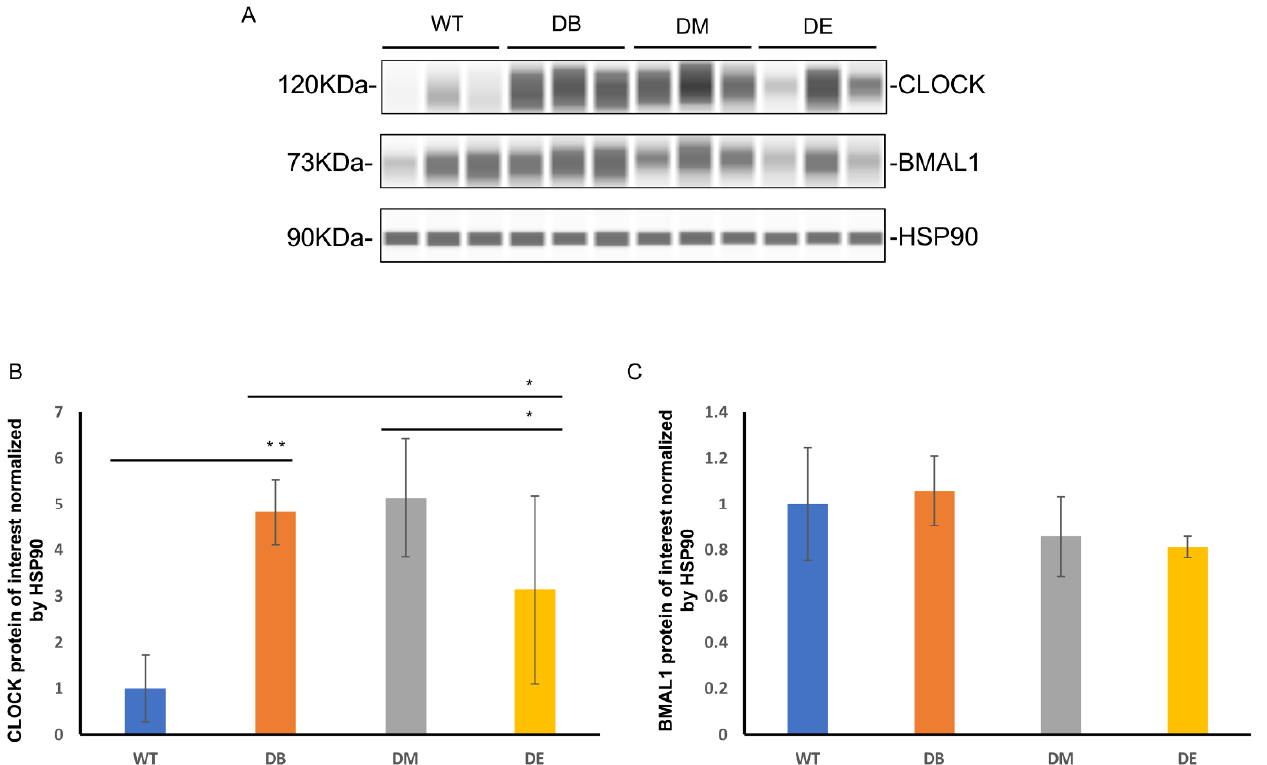
Figure 3. Night exercise is better than morning exercise in relieving the change of CLOCK expression caused by diabetes. ( A ) Wes TM of CLOCK and BMAL1 expression in livers from groups WT, DB, DM, and DE mice. ( B , C ) Statistical evaluation of CLOCK and BMAL1 expression in the liver, as shown in * p < 0.05 and ** p < 0.01, n = 3 – 4.